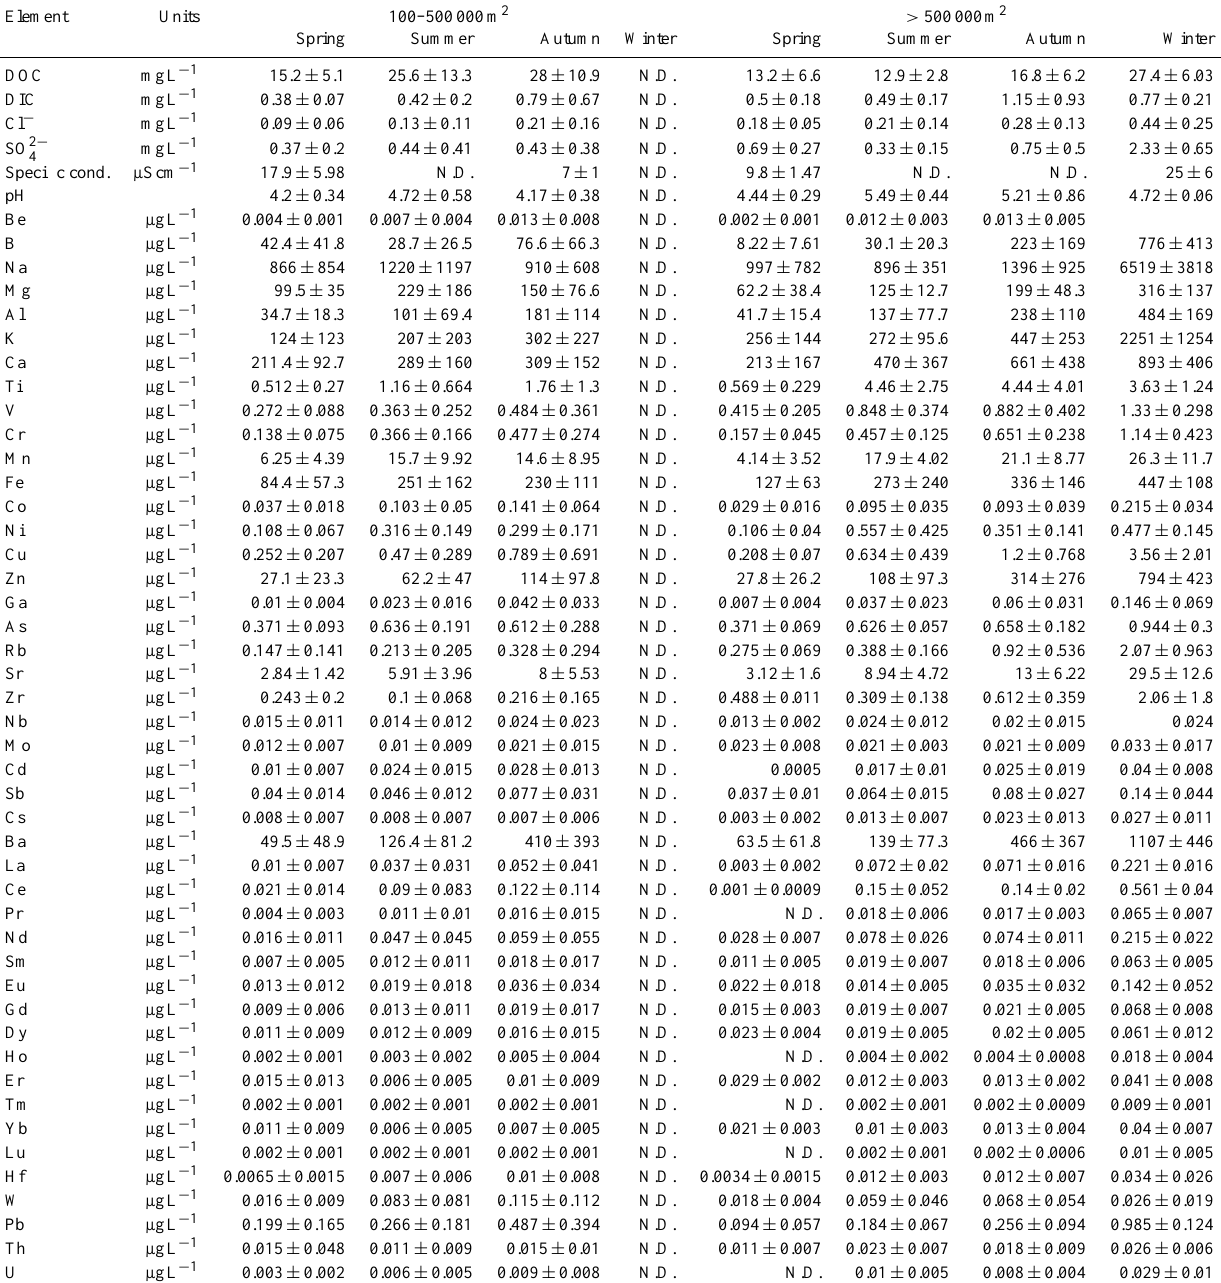
Table 3. Average concentrations and standard deviation ( ± 2 σ ) of major and trace elements during different seasons of the year for two size classes of thermokarst lakes, 100–500000 and > 500000m 2 . Considering all elements simultaneously, the difference between the two size classes is statistically significant ( p = 0 . 007, 0.0008 and 0.00007 for spring, summer and autumn), as follows from the Wilcoxon t test.